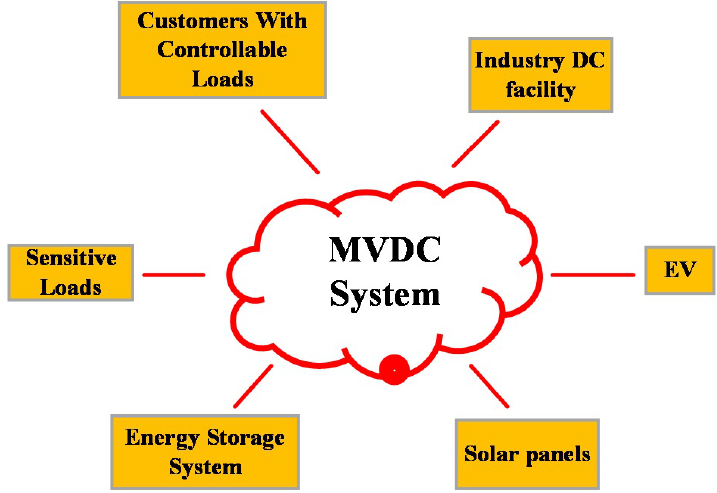
Figure 1. Applications of the medium-voltage DC (MVDC)